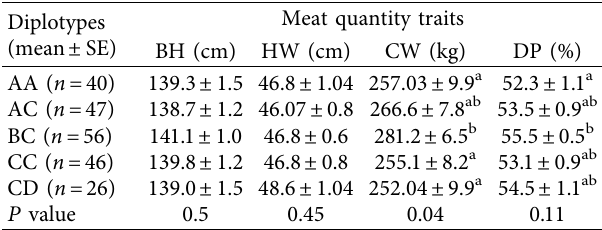
Table 4: Effect of UCP1 gene polymorphism ( P < 0 . 05) on meat quantity traits.